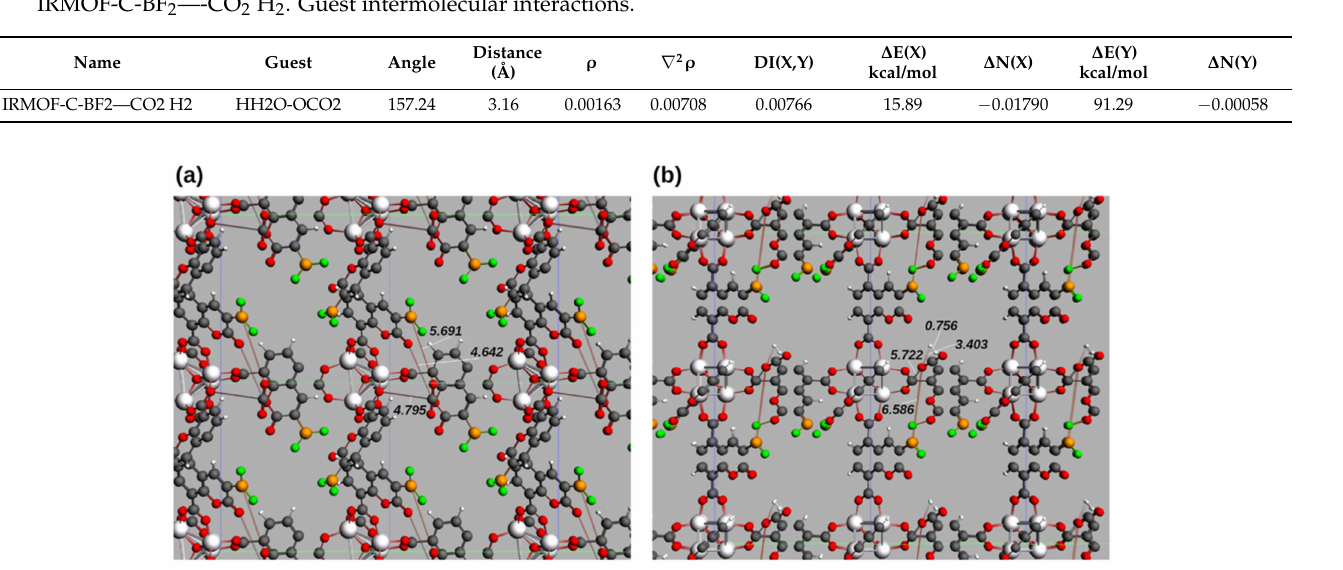
Figure 4. Minimum energy geometry for IRMOF-C-BF 2 unit cell in the presence of ( a ) CO 2 and ( b ) H 2 and CO 2 as guest molecules. The specified distances are shown in Angstrom (Å). Coordinates in xyz format available in the